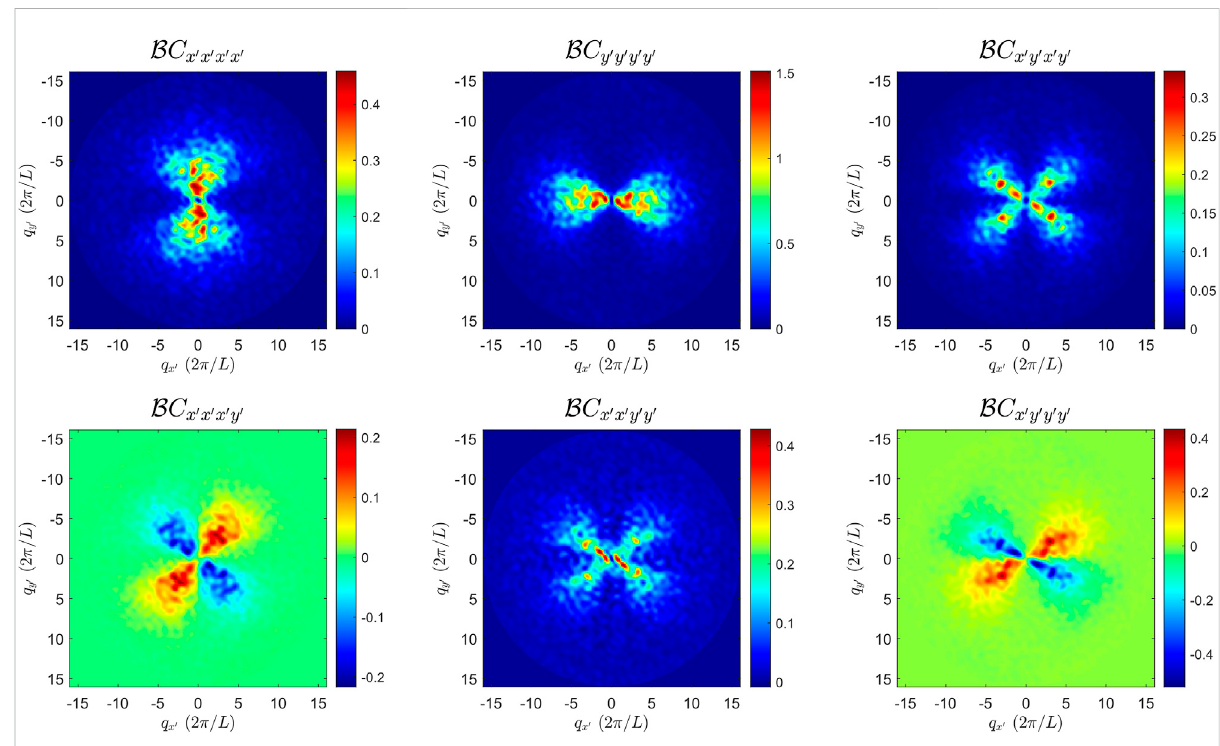
FIGURE 8 Stress correlation functions in the Fourier space averaged over 6 ultrastable states with similar stress states. The mean pressure for the 6 states used in the averaging process is p =8.6±0.7 N/m. All the correlation functions are normalized by B from the VCTG fi tting (Eq. 17). Note